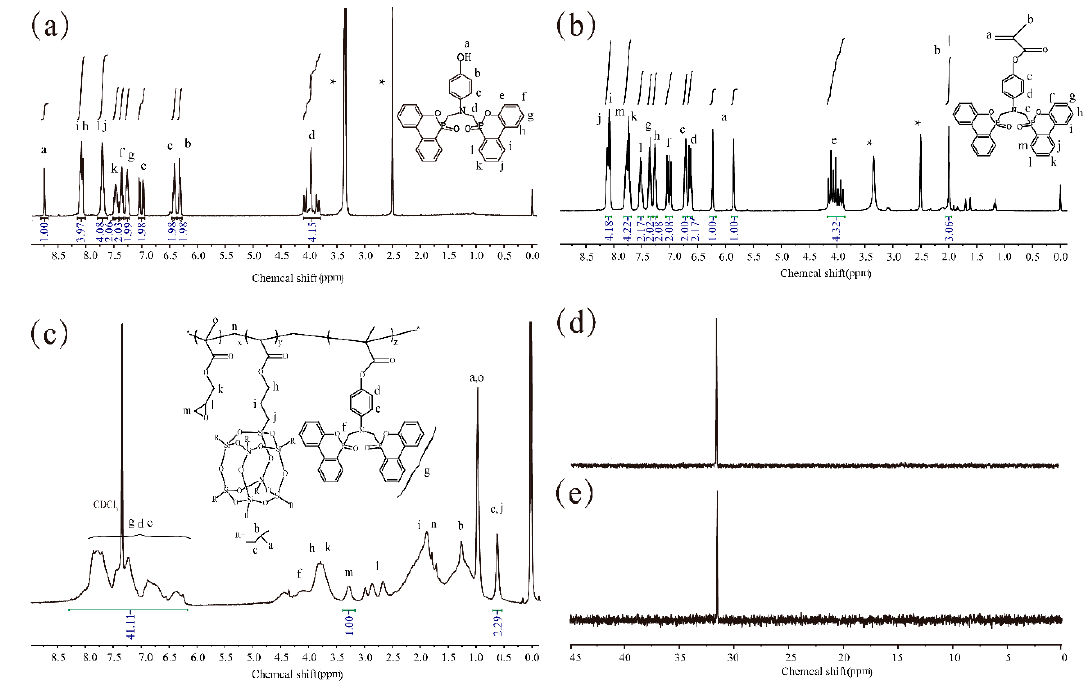
Figure 1. The 1 H NMR, 31 P NMR of OH-bisDOPO ( a,d ), bisDOPOMA ( b,e ), and PDPG ( c ). Figure 2. The gel permeation chromatography (GPC) trace recorded for PDPG.